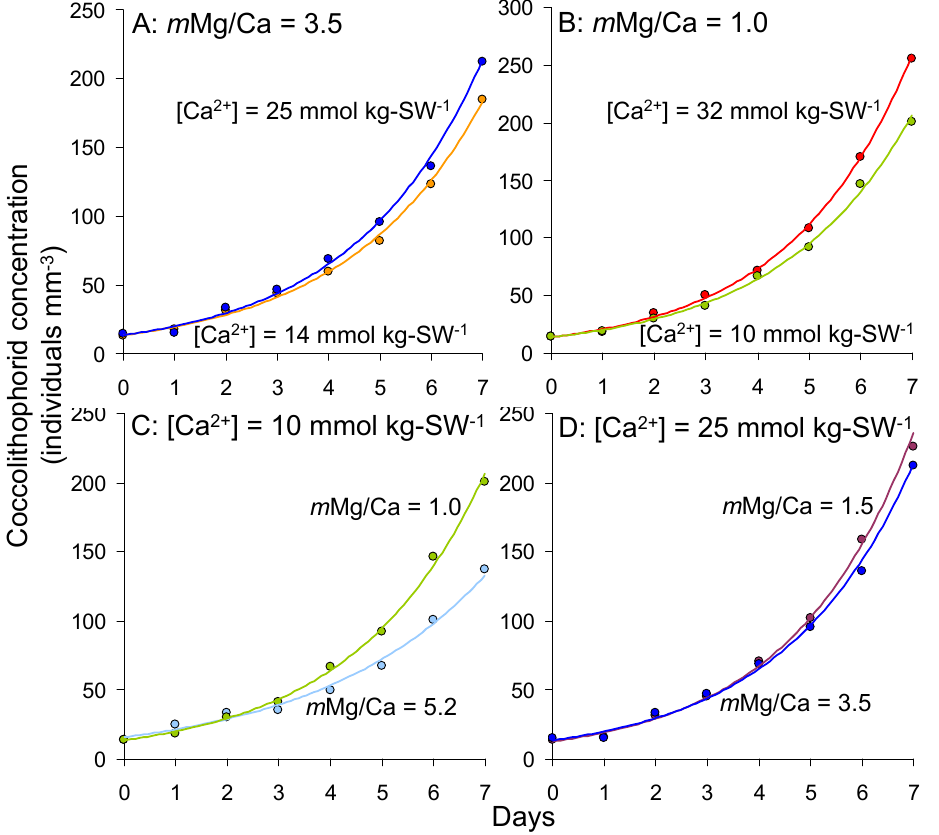
Fig. 13. Effect of seawater Mg/Ca ratio and absolute Ca 2 + concentration on population growth rate of Pleurochrysis carterae . (A) With Mg/Ca ratio fixed at 3.5, elevation of Ca 2 + concentration from 14.1mmolkg-SW − 1 (orange curve) to 25.3mmolkg-SW − 1 (dark blue curve) produced faster population growth. (B) With Mg/Ca ratio fixed at 1.0, reduction of Ca 2 + concentration from 31.6mmolkg-SW − 1 (red curve) to 10.2mmolkg-SW − 1 (green curve) produced slower population growth. (C) With Ca 2 + fixed at 10.2mmolkg-SW − 1 , reduction of Mg/Ca from 5.2 (light blue curve) to l.0 (green curve) produced faster population growth. (D) With Ca 2 + fixed at 25.3mmolkg-SW − 1 , elevation of the Mg/Ca ratio from 1.5 (purple curve) to 3.5 (dark blue curve) yielded slower population growth. Experiments with Coccolithus neohelis yielded similar results. From Stanley et al.